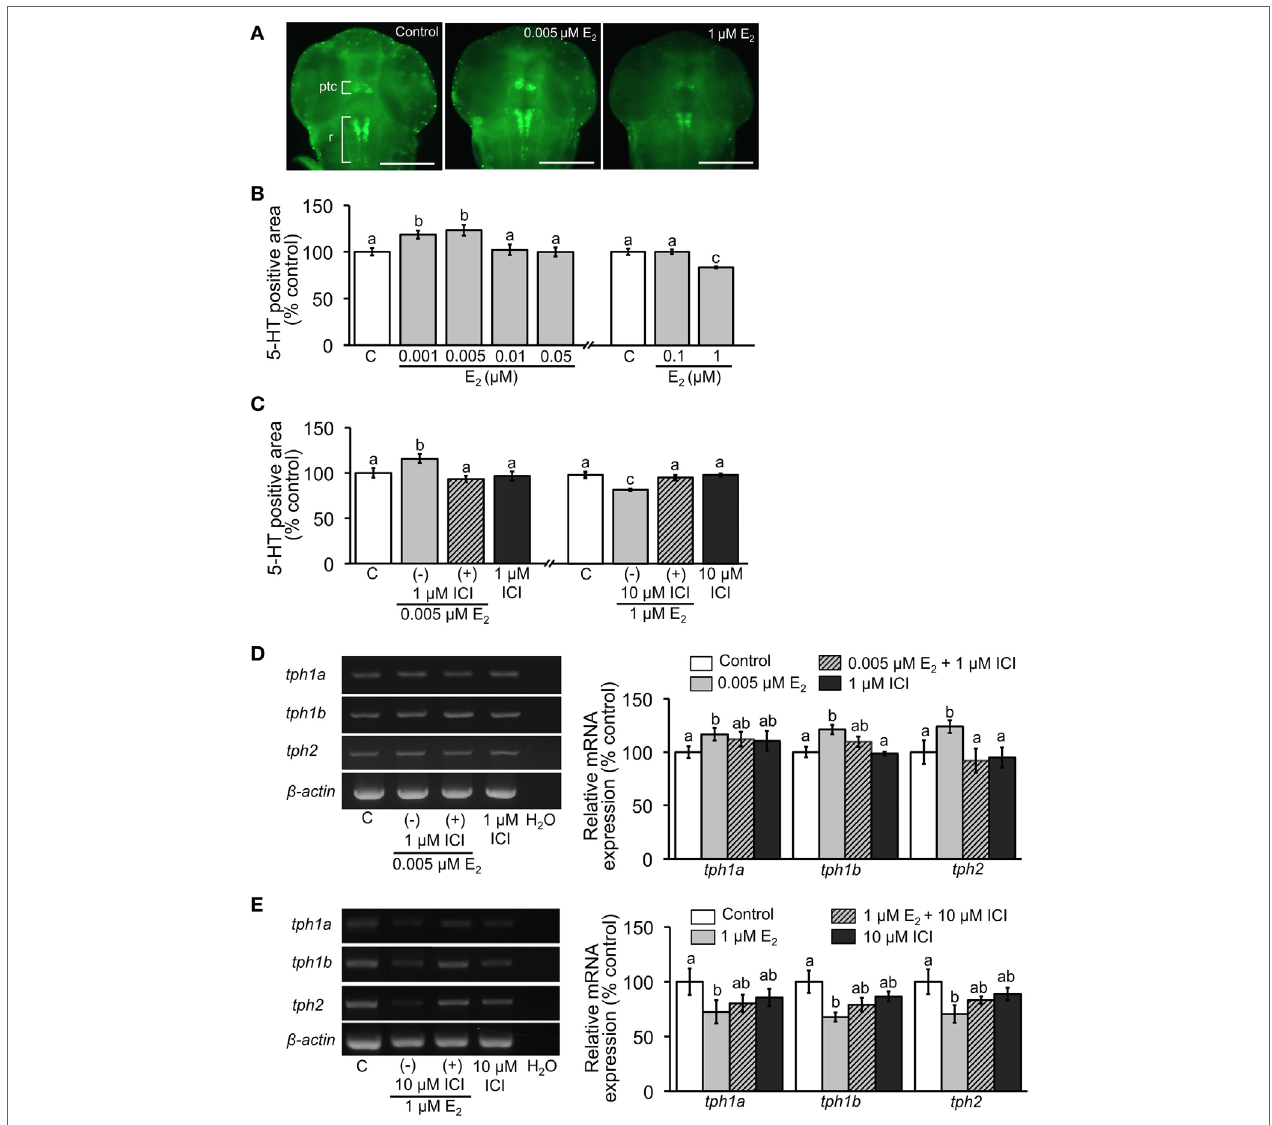
FigUre 1 | Effect of E 2 on 5-HT-positive area and relative expression of tph isoforms. (a) Representative images of ventral view of head region showing 5-HT-positive cells in pretectal and thalamic complex (ptc) and raphe (r) at 2 dpf. Scale bar: 200 µm. (B,c) Measurements of the area of 5-HT-positive neurons in the experiment of E 2 exposure and co-incubation of E 2 and ICI, respectively. (D,e) Semi-quantitative PCR for expression of tph isoforms in 4 dpf larvae in the experiments of exposure to low and high doses of E 2 and co-incubation with ICI, respectively. Data are presented as a mean ± SEM. Different letters in each graph indicate significant differences ( p <